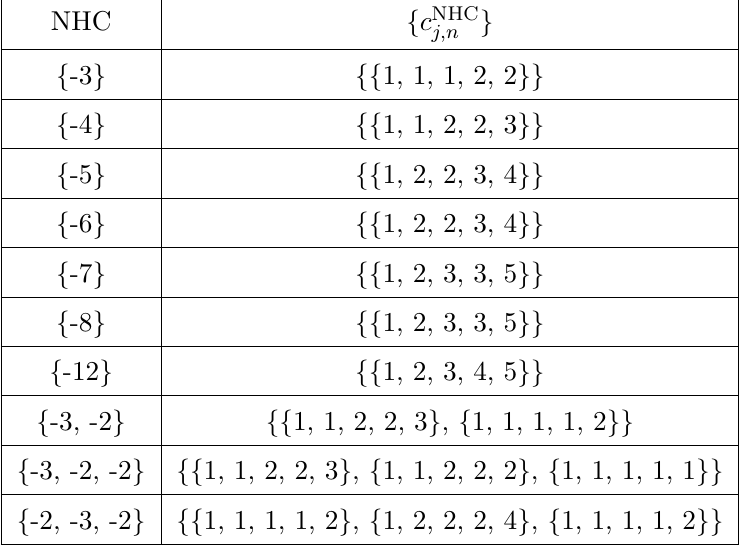
Table 5. The minimal vanishing orders of sections a 1 ; 2 ; 3 ; 4 ; 6 over